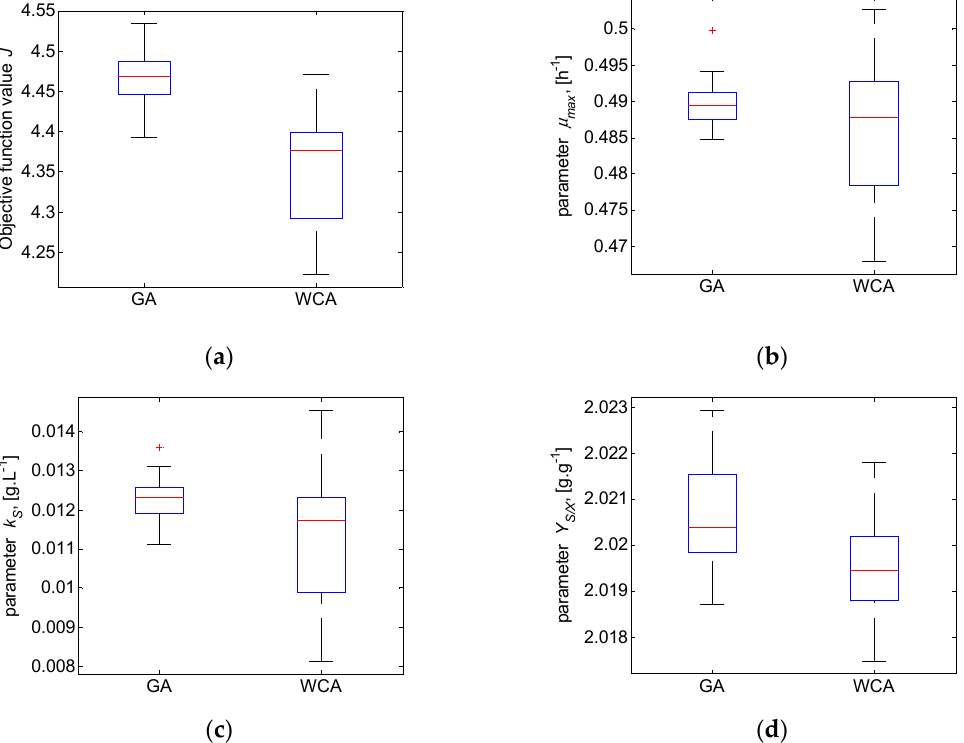
Figure 5. Case study 1 : box plot for: ( a ) objective function value J and model parameters ( b ) µ max ; ( c ) k S ; ( d ) Y S / X .